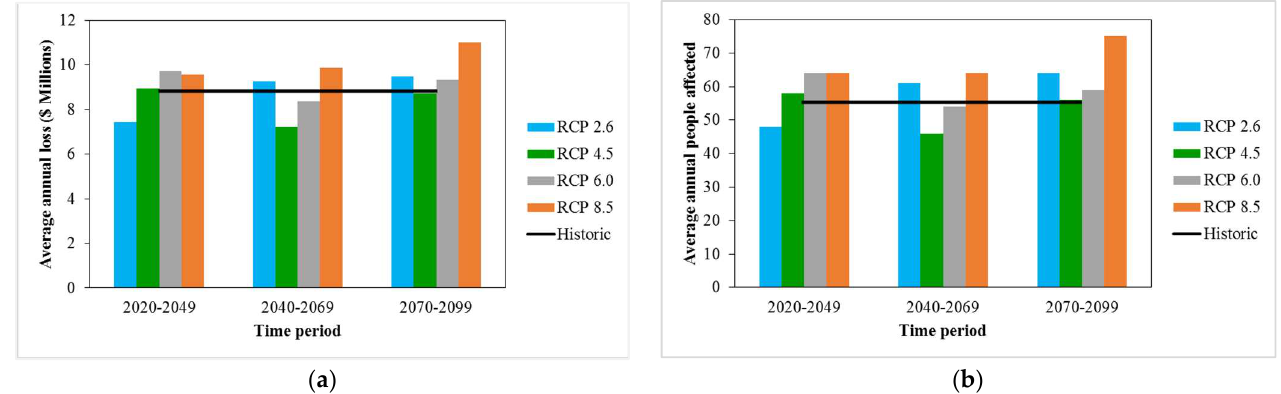
Figure 13. Average annual impacts plots. ( a ) Economic loss; ( b ) affected people.